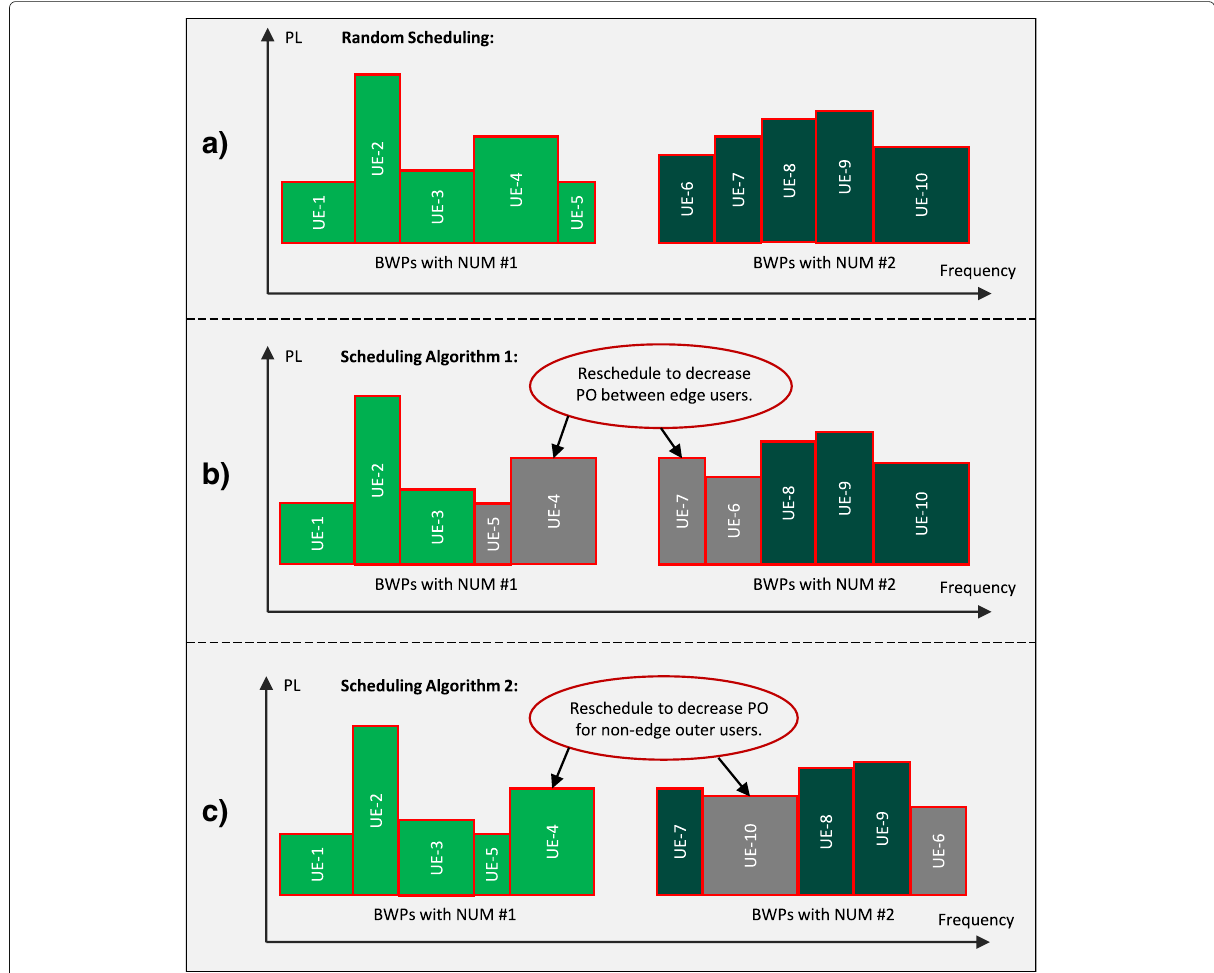
Fig. 6 Representation of proposed PDB scheduling algorithms to decide on edge users for multi-numerology systems. There is a fixed guard band between two different numerologies. It is assumed that PO between UE-4 and UE-7 is less than the PO between UE-4 and UE-10. Moreover, PO between UE-4 and UE-10 is less than the PO between UE-3 and UE-6. a ) Random Scheduling. b ) Scheduling Algorithm-1. c ) Scheduling Algorithm-2